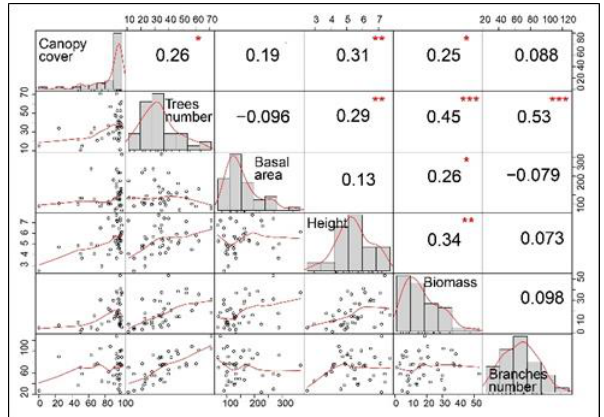
Figure 3. Correlation by Kendell’s tau between canopy cover, basal area, tree height, and biomass at plot level for all plots (n= 43). p< 0.05 *, p<0.01 **, p<0.001 ****** The histograms show the distribution of the variables and que scatterplots the correlation between the variables.